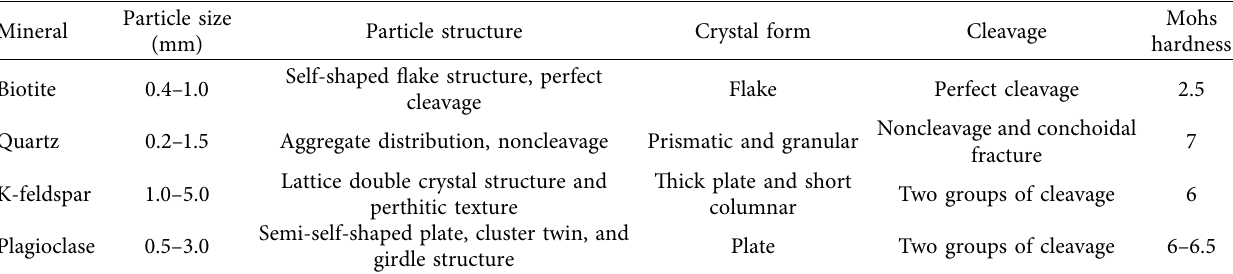
Figure 2: Microfeatures of granite. (a) Polarizing microscope features. (b) Mineral morphology (B: biotite, Q: quartz, K: K-feldspar, and P: plagioclase). Table 2: Main mineral morphology features of